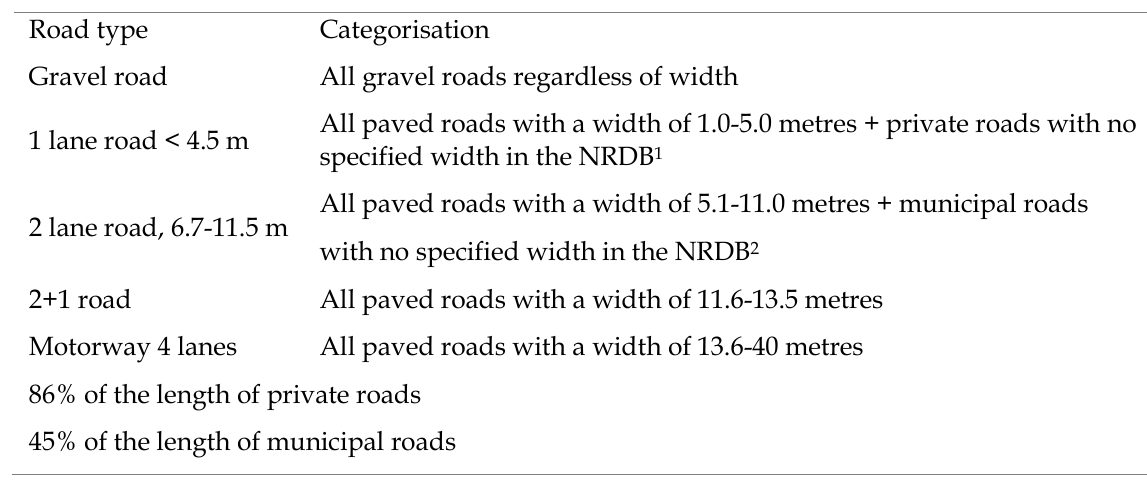
Table A4. Maintenance and reinvestment of road infrastructure: how the road infrastructure stock was divided into standard measures representative of the standard measures in Klimatkalkyl 4.0. The road length was received from the NRDB via Lastkajen (Swedish Transport Administration, 2016b).